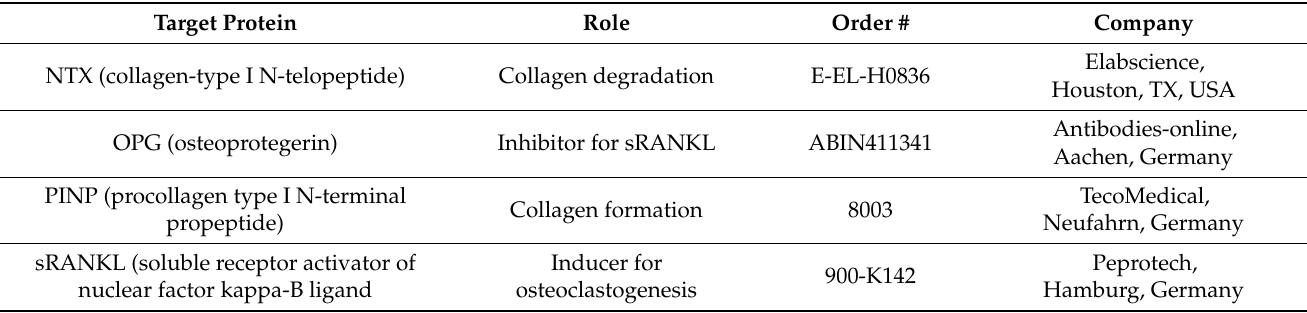
Table 1. Overview on the used ELISA